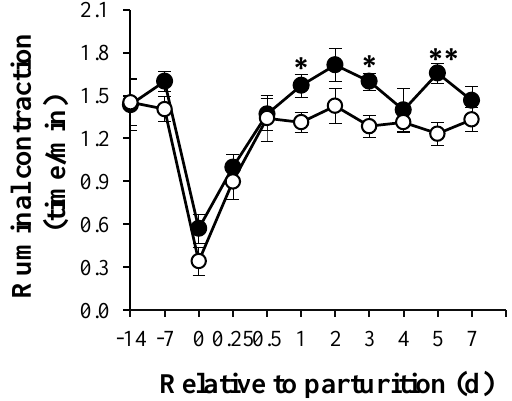
Figure 2. Ruminal contractions (time/min) during, before and following parturition. Symbols: (–●–) represents to the cows in difructose anhydride (DFA) group that received DFA III supplement, and (–○–) represents to the cows in CONT group that did not receive DFA III. The vertical bars on time-point measurements indicate the standard errors of the mean. * and ** indicate statistically differences between the groups at p<0.05 and p<0.01,